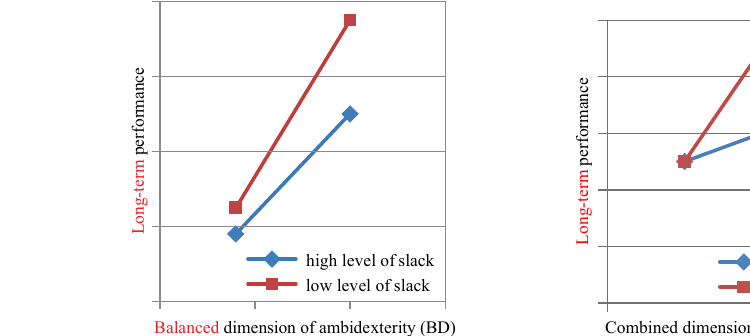
Combined dimension of ambidexterity Fig. 2. Conditional effects plot of CD on different levels of organizational slack